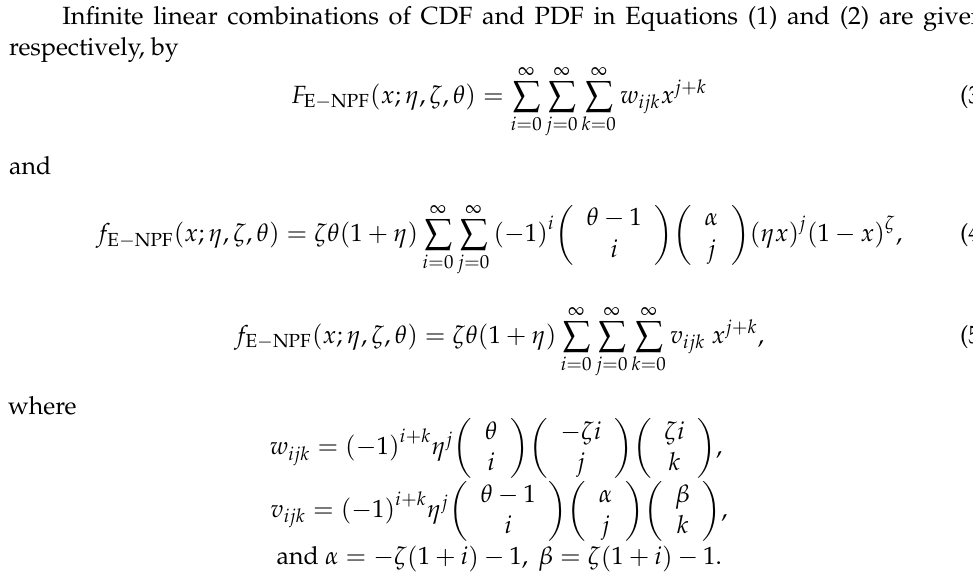
Figure 2. Plots of the hazard rate function (HRF) of the E-NPF model for different values of its parameters ( a , b ).